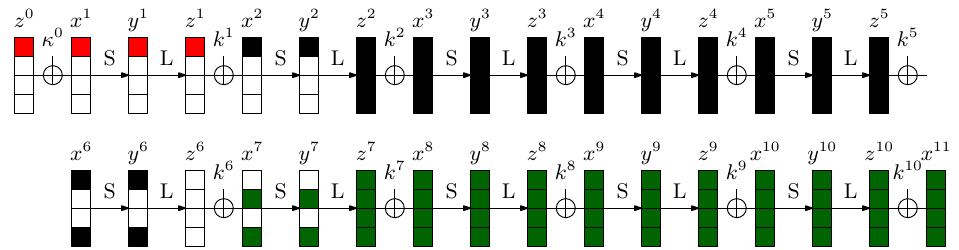
Figure 9: Generalized Demirci-Selçuk attack on 10 round version of BipBip.